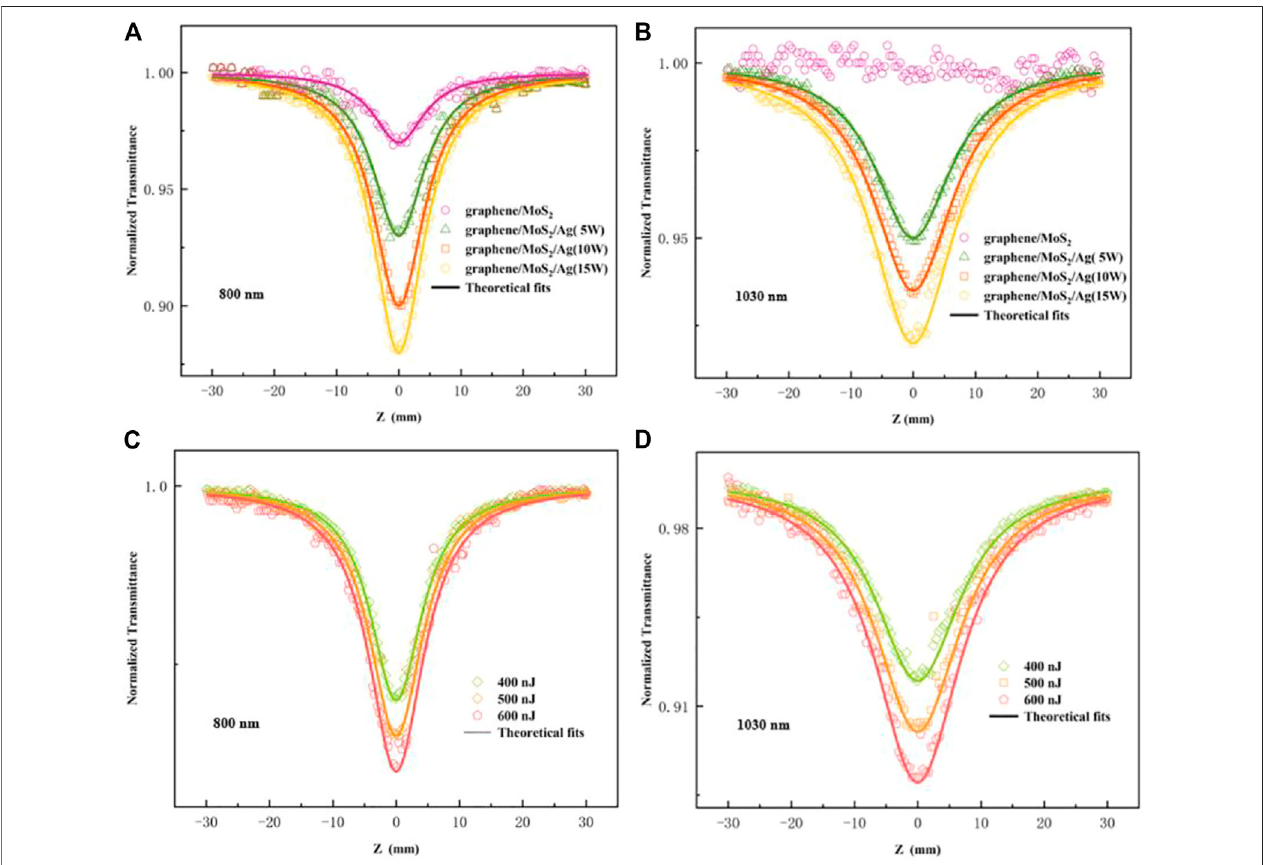
FIGURE 6 | The OA Z-scan signals of A and B thin fi lms at 800 (A) and 1,030 nm (B) . The OA Z-scan signals of B 3 thin fi lm at 800 (C) and 1,030 nm (D) under different excitation conditions.